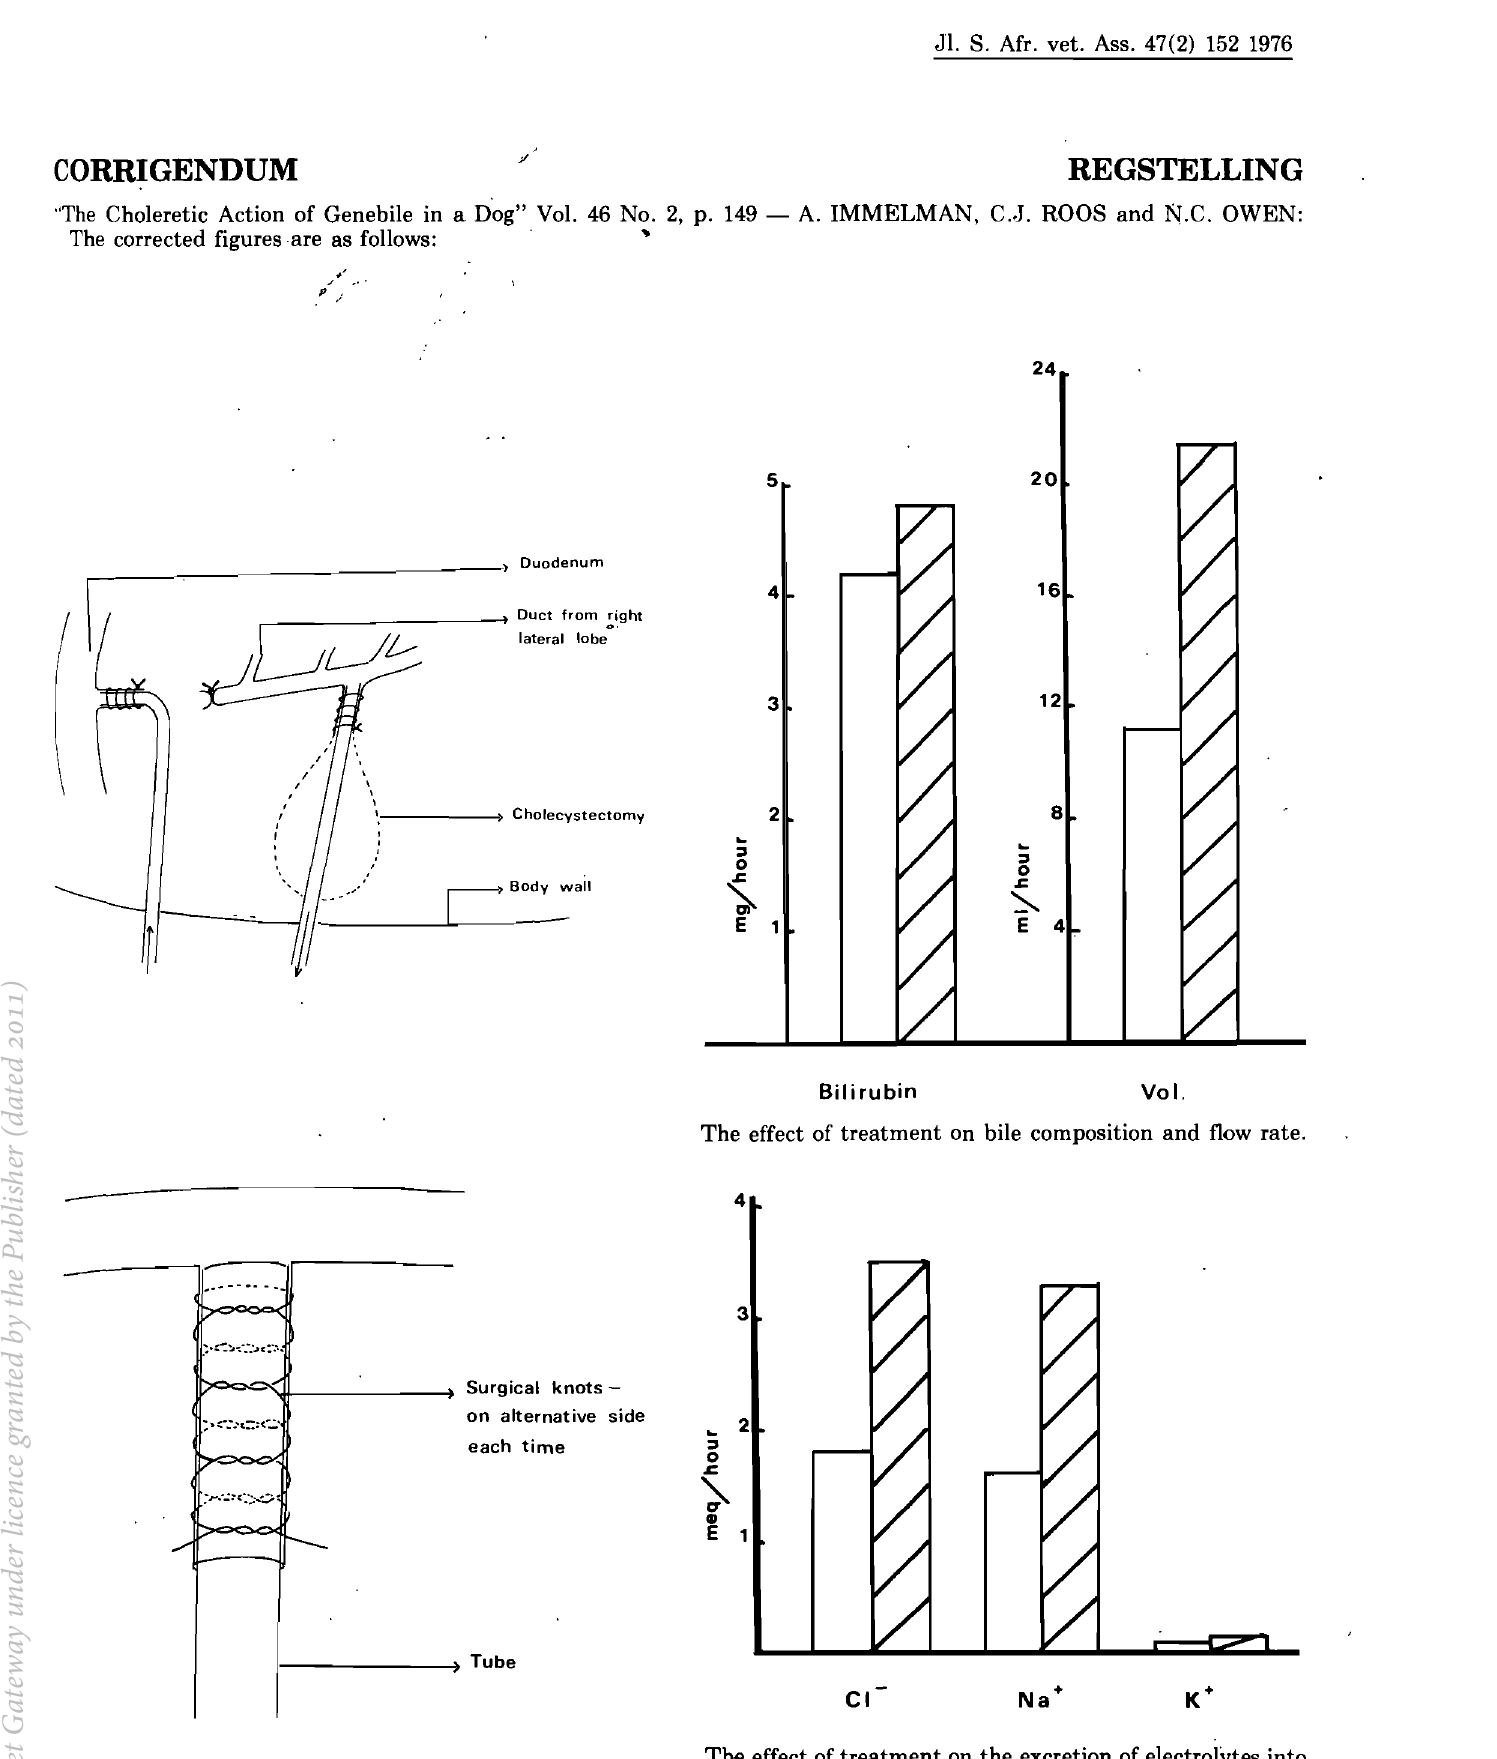
The effect of treatment on the excretion of electrolytes into bile. Fig. 2 The height of each column represents the mean value for the three trials. . o Before treatment f2l After treatment.